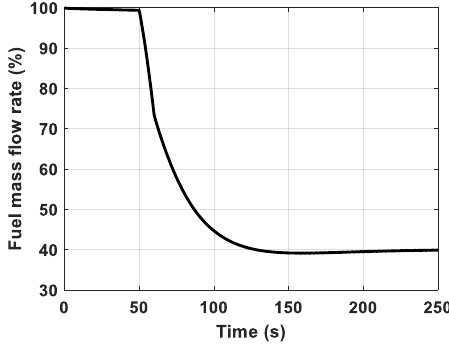
Figure 19. Fuel mass flow rate time history.